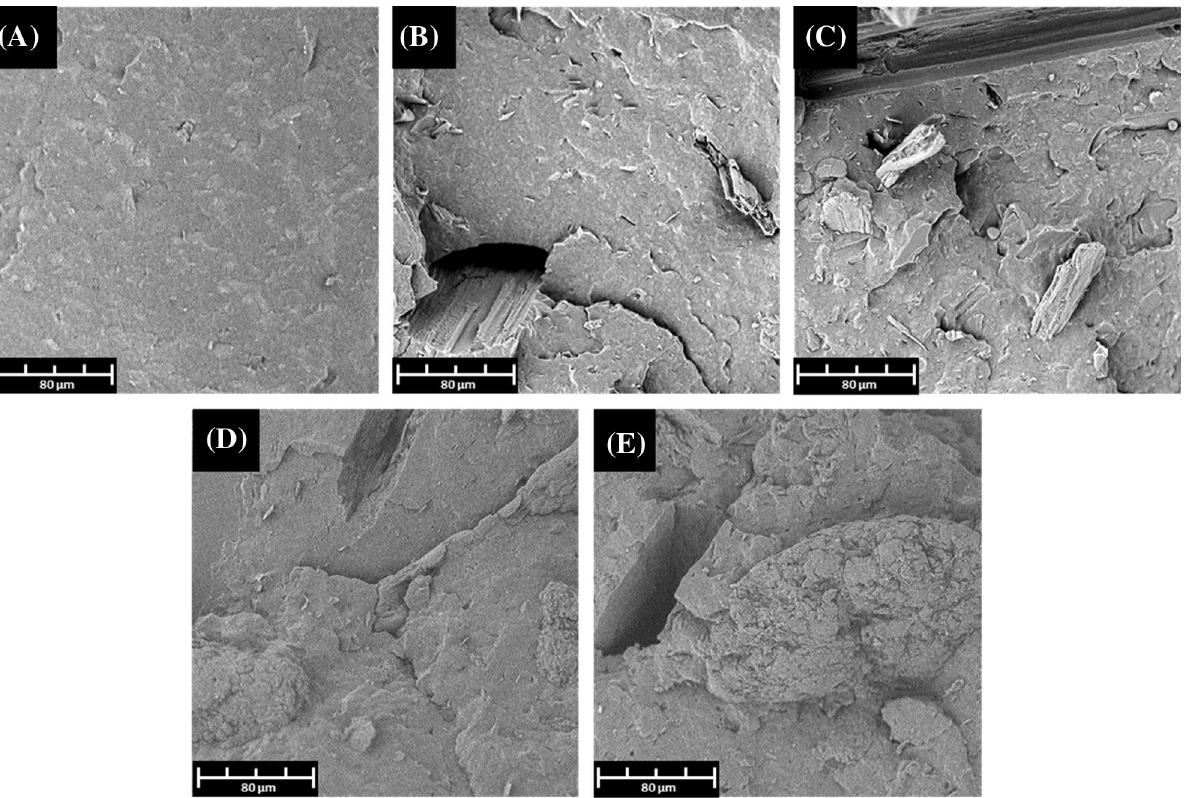
Figure 3. SEM morphology of ( A ) PHBV, ( B ) PHBV/Misc (85/15), ( C ) PHBV/Misc (75/25), ( D ) PHBV/DDGS (85/15) and ( E ) PHBV/DDGS (75/25) notched IZOD impact samples after